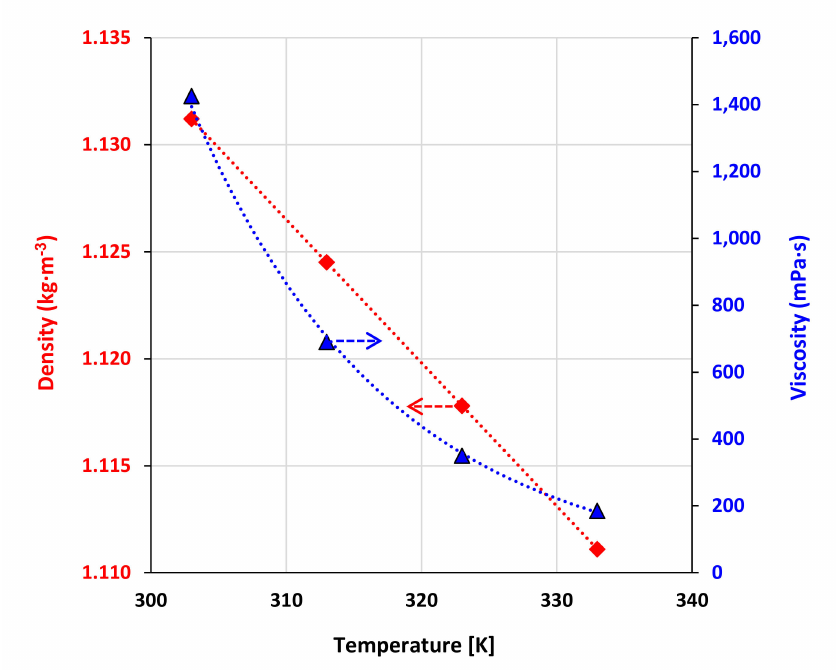
Figure 5. Density and viscosity as a function of temperature. The density and viscosity decrease as temperature increases. Red line represents the density and blue line represents the viscosity of the DES. The arrows show the y-axis of respective fitted